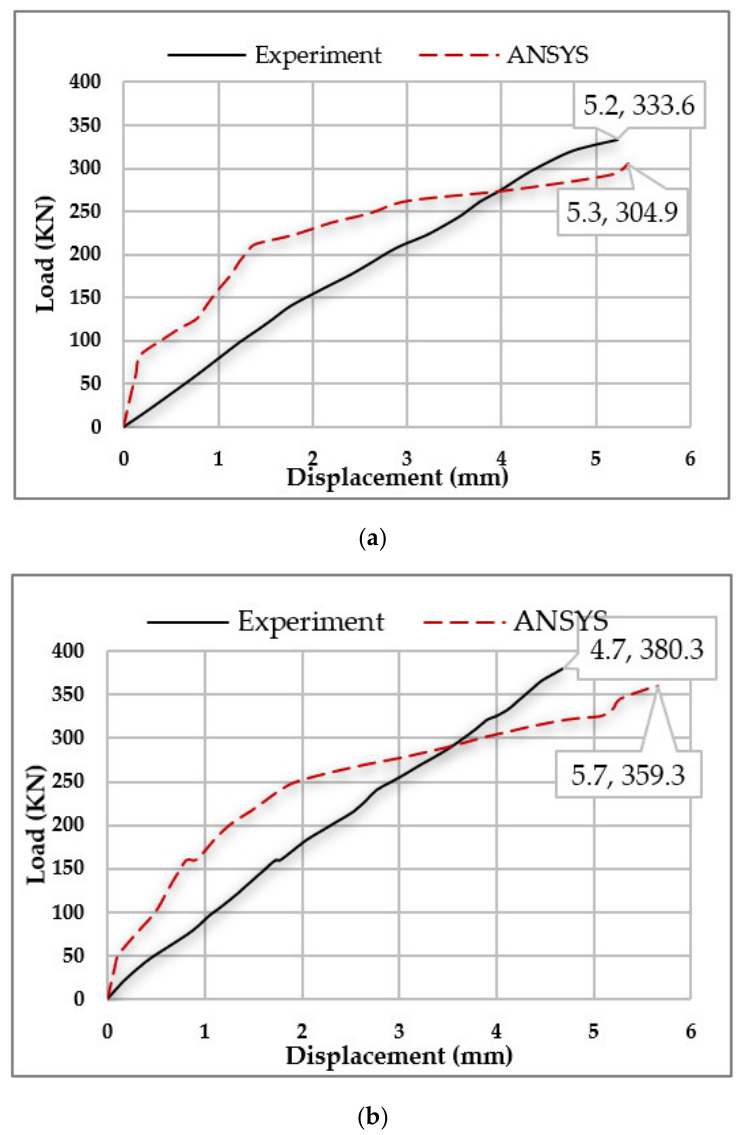
Figure 5. Load-Displacement Curves for Experimental Specimens Vs. Their Simulation on ANSYS.